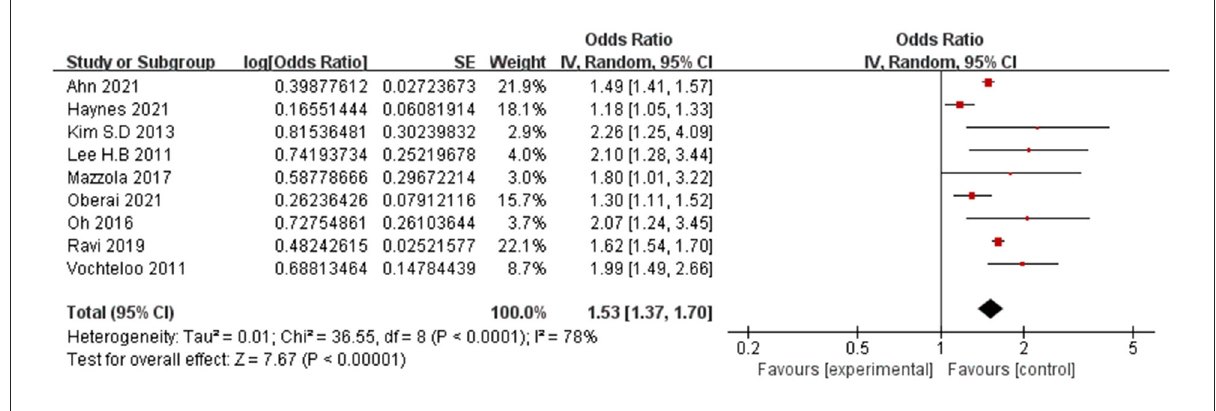
FIGURE5 Forest plot for